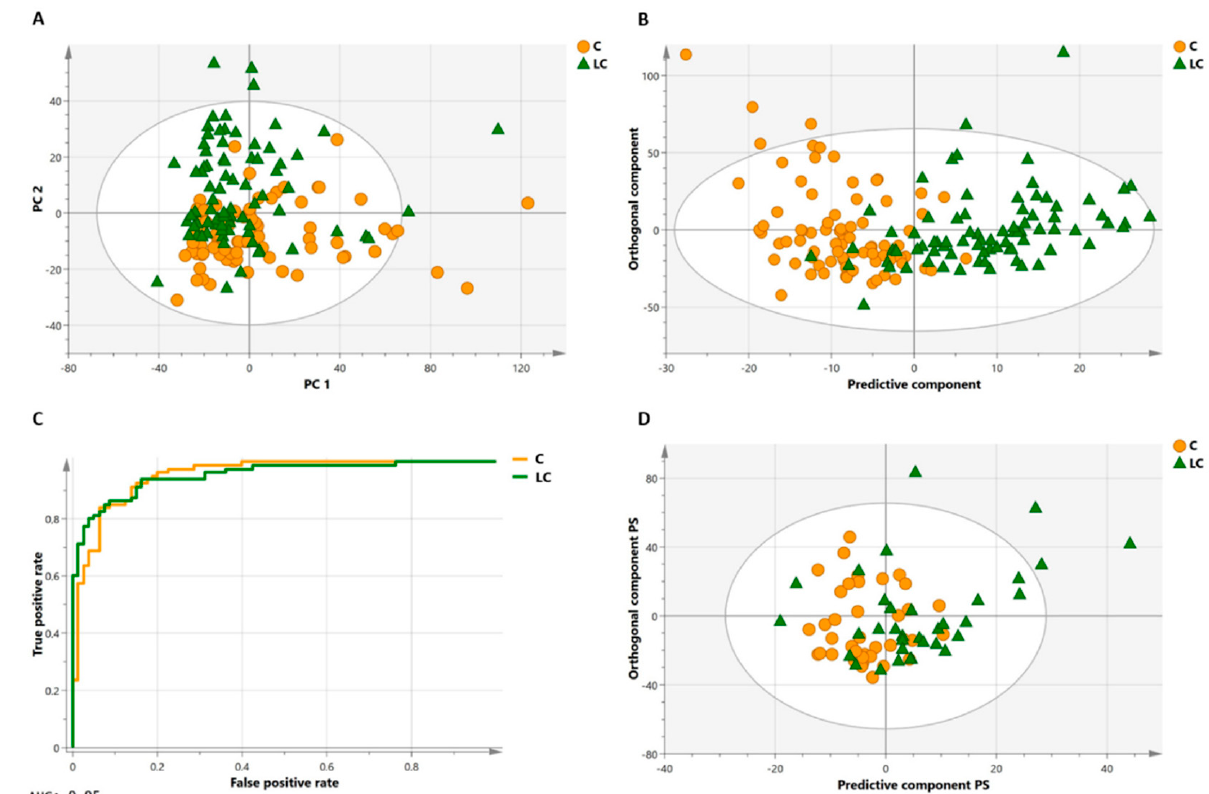
Figure 4. Multivariate statistical analyses on a large lung cancer and control cohort. Principal component analysis (PCA, ( A )) of the training cohort illustrates the clustering of the two groups (80 controls, orange circles; 80 lung cancer patients, green triangles) in a study performed by Derveaux et al. [49]. In orthogonal partial least squares discriminant analysis (OPLS-DA, ( B )), a regression model is constructed between the multivariate data and a response variable that contains class information (control, lung cancer). The OPLS-DA score plot in B has a specificity of 93% and sensitivity of 85%, meaning that 85% of all lung cancer patients are correctly classified by the trained OPLS-DA model (trained classifier). The high area under the curve of 0.95 of the receiver operating characteristic (ROC) curve of the trained classifier ( C ) demonstrates that the model has an excellent capability to distinguish between the two groups. An independent subject cohort ( D ) is used to validate the classification model. Here, validation of the OPLS-DA classifier shows a sensitivity and specificity of 74%. Figure adapted from reference [49], open access policy.